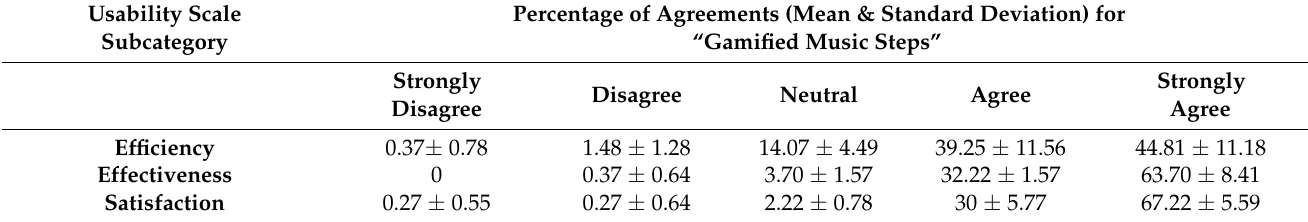
Table 5. Summary of responses for the Usability evaluation of “Gamified Music Steps”.